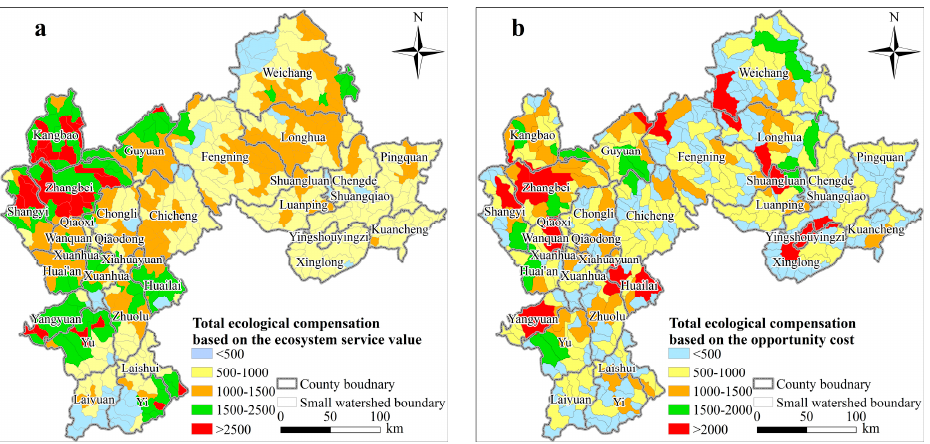
Figure 4. The total ecological compensation value based on the ( a ) ecosystem service value and ( b ) opportunity cost on the small watershed scale in the study area (unit: CNY 10,000).